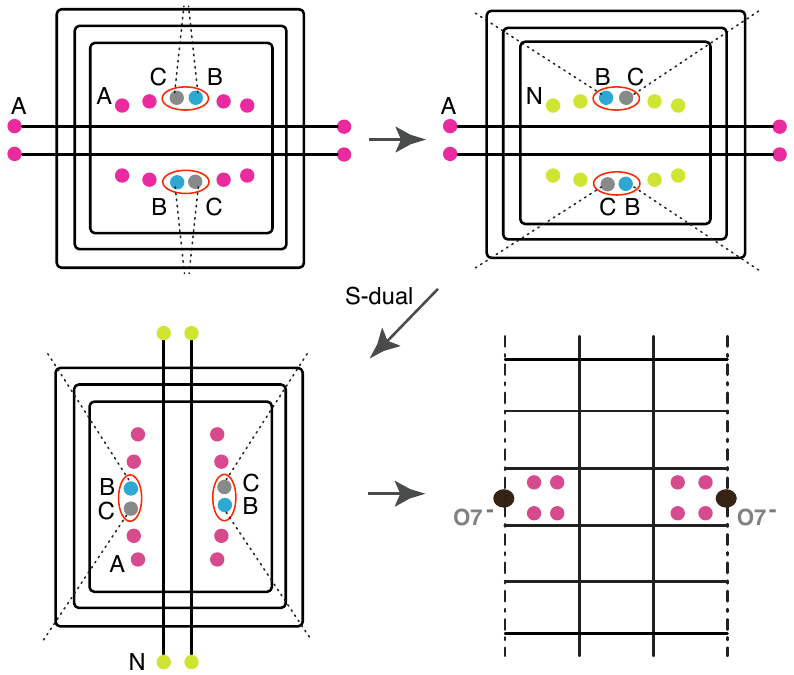
Figure 50 . The (cid:12)rst (cid:12)gure is a simpli(cid:12)ed version of the right of (cid:12)gure 49 for 6d [8] Sp(2) SU(4) (cid:0) (cid:0) (cid:0) SU(4) SU(4) [4] quiver. The 7-branes are distributed and combined to form an S-dual invariant (cid:0) (cid:0) 7-brane combination. The second (cid:12)gure is the rearrangement of these 7-branes via monodromies explained in section 5.1. The third one is the result of S-dual action of the second one. The last one is the corresponding brane con(cid:12)guration showing 5d [4] Sp(3) SU(6) Sp(3) [4]. (cid:0) (cid:0) (cid:0) (cid:0) 5.3 6d [8+ m ] (cid:0) Sp( N ) (cid:0) SU(2 N (cid:0) m ) (cid:0) SU(2 N (cid:0) 2 m ) (cid:0) SU(2 N (cid:0) 3 m ) (cid:0) : : T T T T